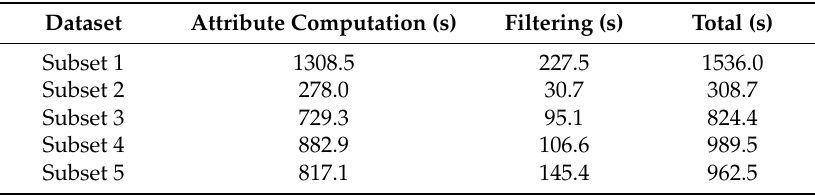
Table 3. Time costs of filtering.